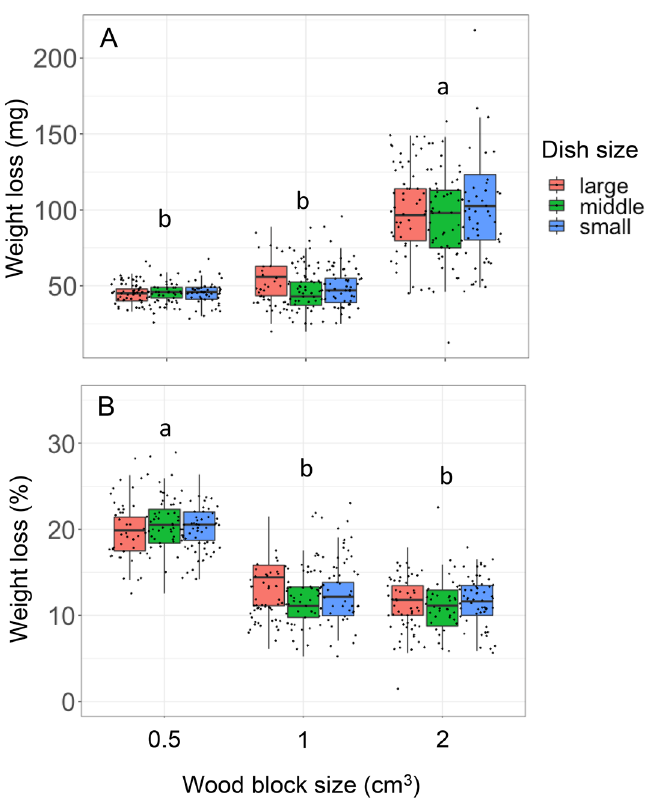
Figure 3. Absolute weight loss ( A ) and percentage weight loss relative to the original weight ( B ) of wood blocks after 2 months of P. velutina colonization + 27 days of soil microcosm incubation. Different lowercase letters indicate significant differences between wood block sizes (Nemenyi test, P < 0.05). N = 50.